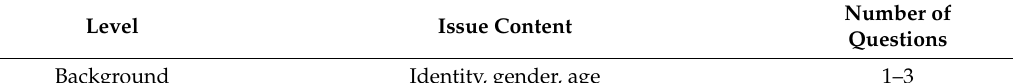
Table 1. Initial questionnaire issue